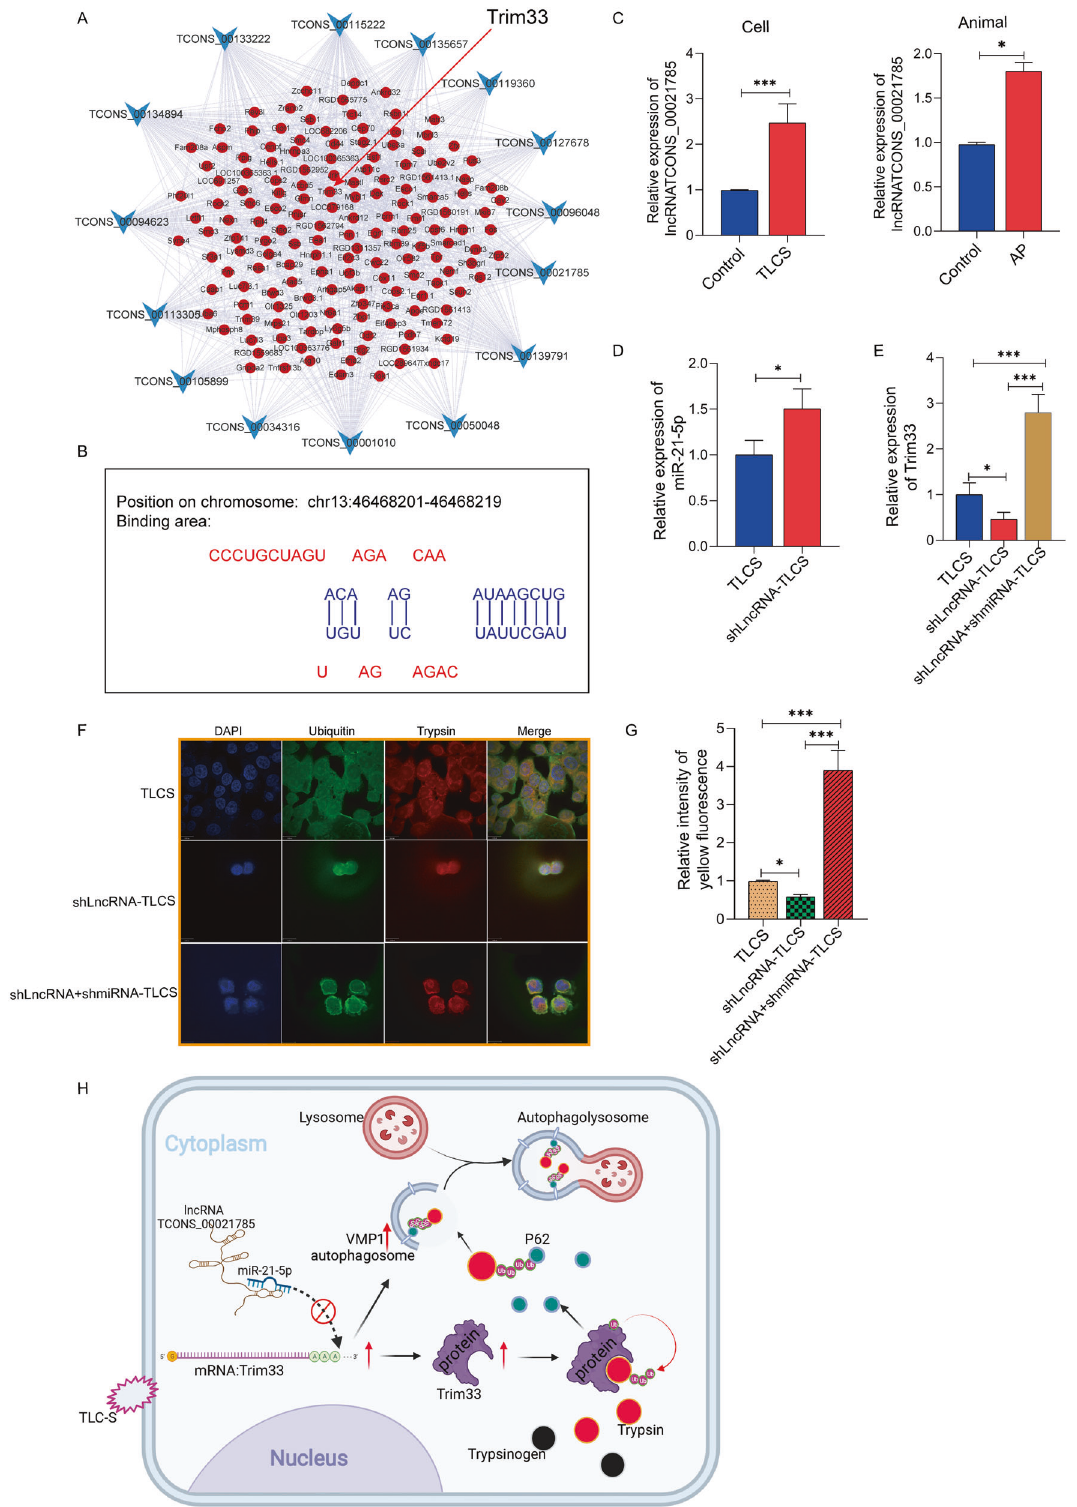
Fig. 8 lncRNA TCONS_00021785 can bind miR-21-5p to regulate Trim33. A Construction of a co-expression network of LncRNA and mRNA; B predicted lncRNA TCONS_00021785 can bind miR-21-5p; C RT-PCR con fi rmed that lncRNA TCONS_00021785 was highly expressed in the AP cell model and the AP rat model; D , E detect the expression of miR-21-5p and Trim33; F detect the activation of trypsinogen in each group. G Its fl uorescence intensity represents the activated trypsinogen. H When acinar cells are damaged by external stimuli, lncRNA TCONS_00021785 can competitively bind miR-21-5p to upregulate Trim33 ( t -test, *** p < 0.001, ** p < 0.01, * p < 0.05).